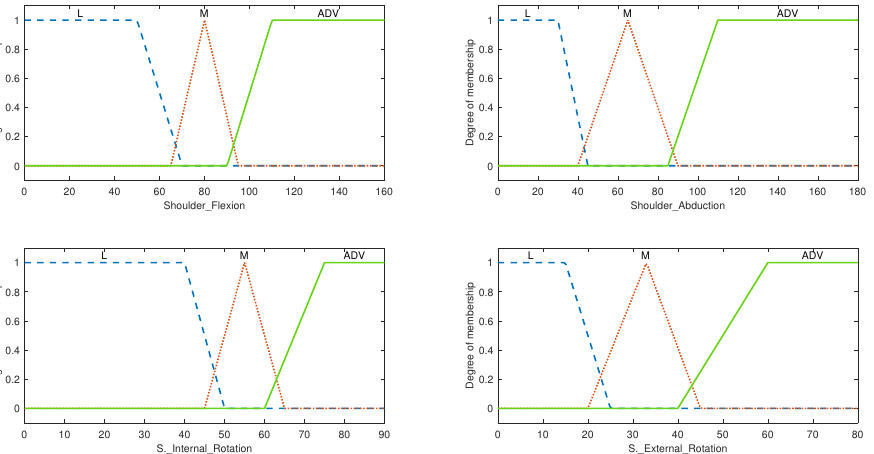
Figure 3. The membership function plot for level of exercise input, where L represents low ROM, M represents medium ROM, and ADV represents advanced ROM.